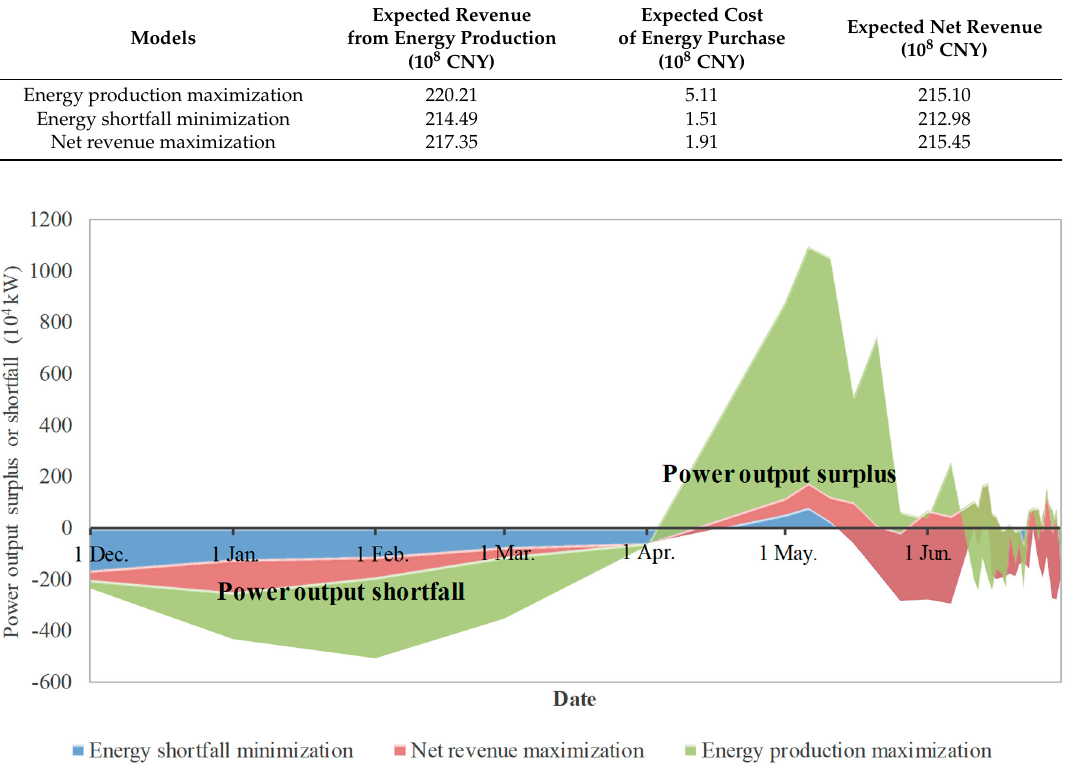
Figure 8 . Power output shortfall and surplus trajectories under different models. Figure 8. Power output shortfall and surplus trajectories under different